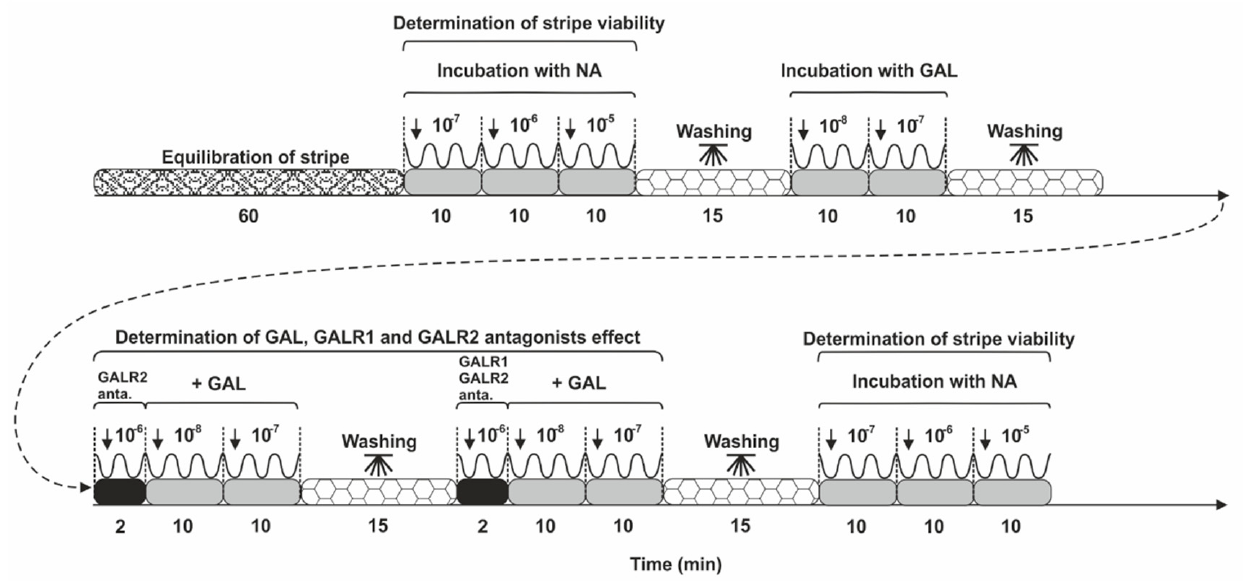
Figure 6. Scheme of the management of stripes of the uterus. NA—noradrenaline, GAL—galanin, GALR2 anta.—GAL receptor subtype 2 antagonist, GALR1/GALR2 anta.—GAL receptor subtypes 1 and 2 antagonist. The concentrations of these factors are given in moles.